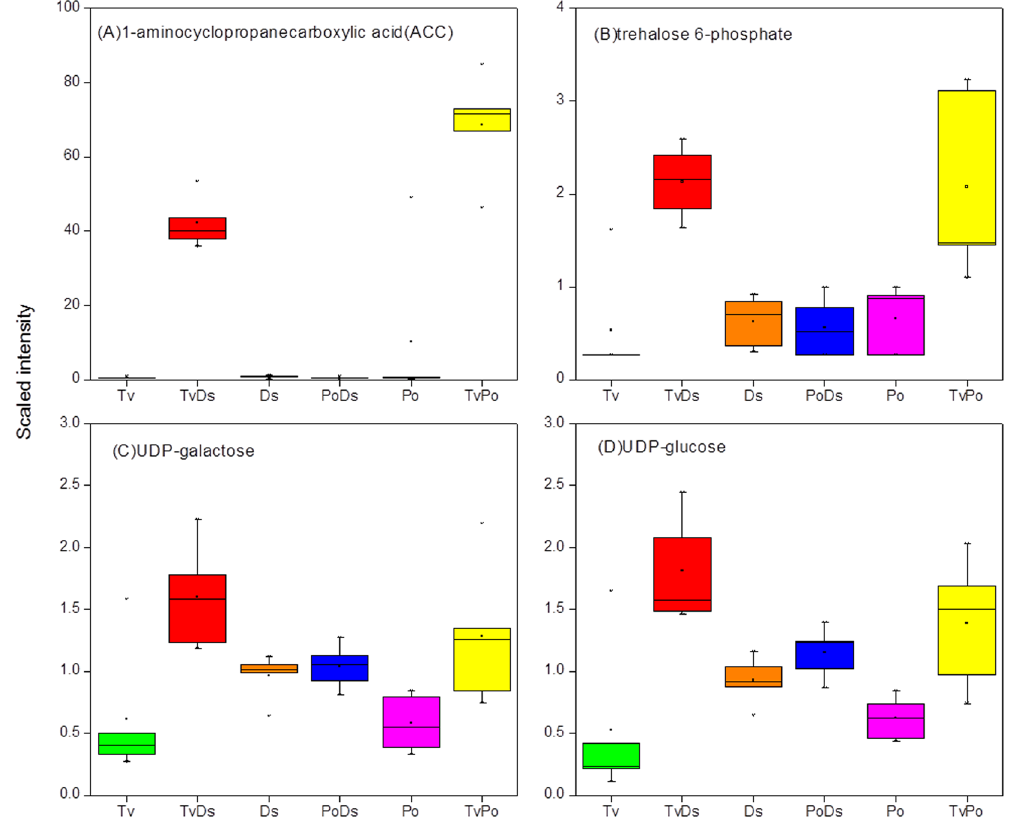
Figure 7. The metabolites only significantly increase in two interactions. ( A ) 1-aminocyclopropanecarbolylic acid (ACC); ( B ) Trehalose-6-phosphate, ( C ) UDP-glucose, ( D )